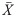
The boxplots of the CARLout values of the synthetic X¯ chart different values of δ when ARL0 = 370.4, m = 50 and n = 5.